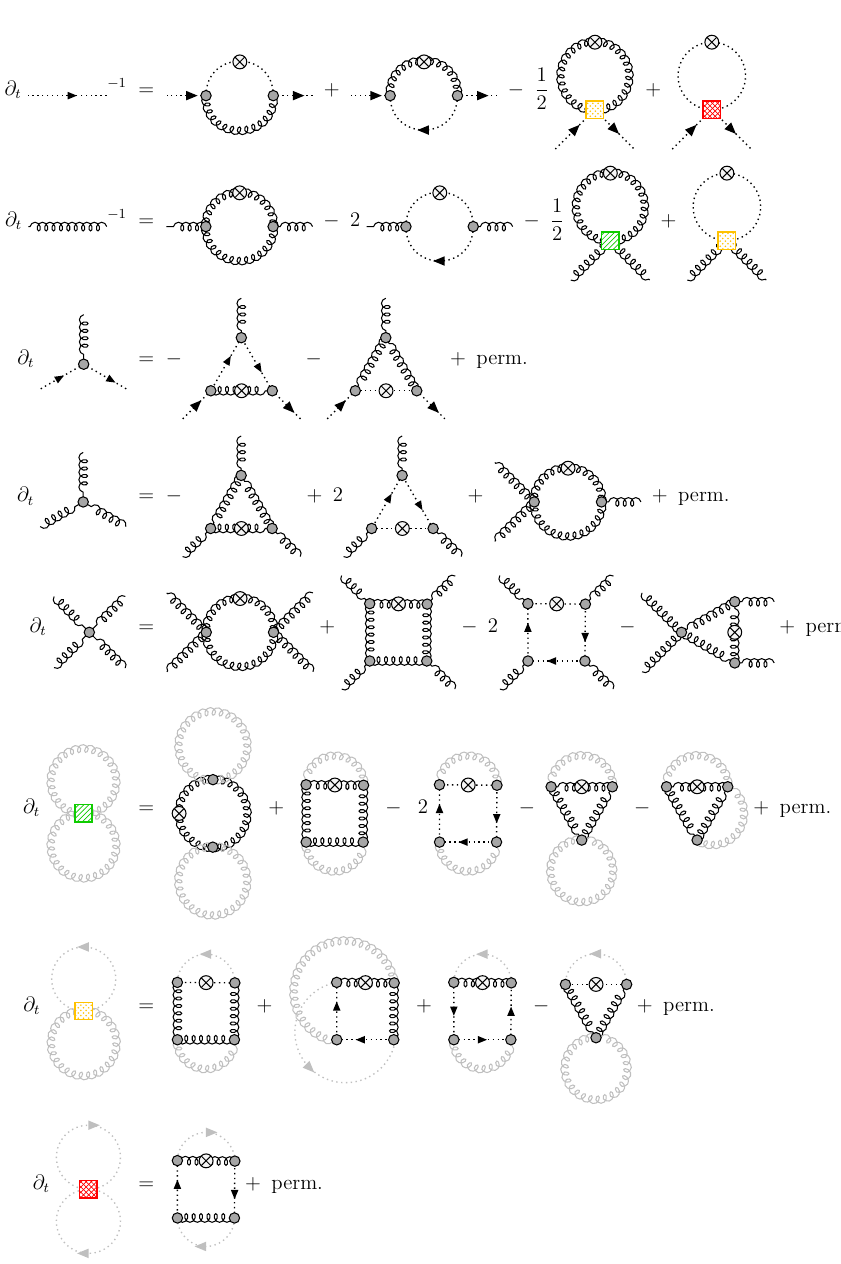
Figure 2: Diagrams that contribute to the truncated flows of propagators and vertices. While filled circles denote dressed (1PI) vertices, the squares denote the tadpole ver- tices explained in subsection 2.2. Shaded lines indicate the projection procedure of the tadpoles vertices. Permutations include not only (anti-)symmetric permutations of external legs but also permutations of the regulator